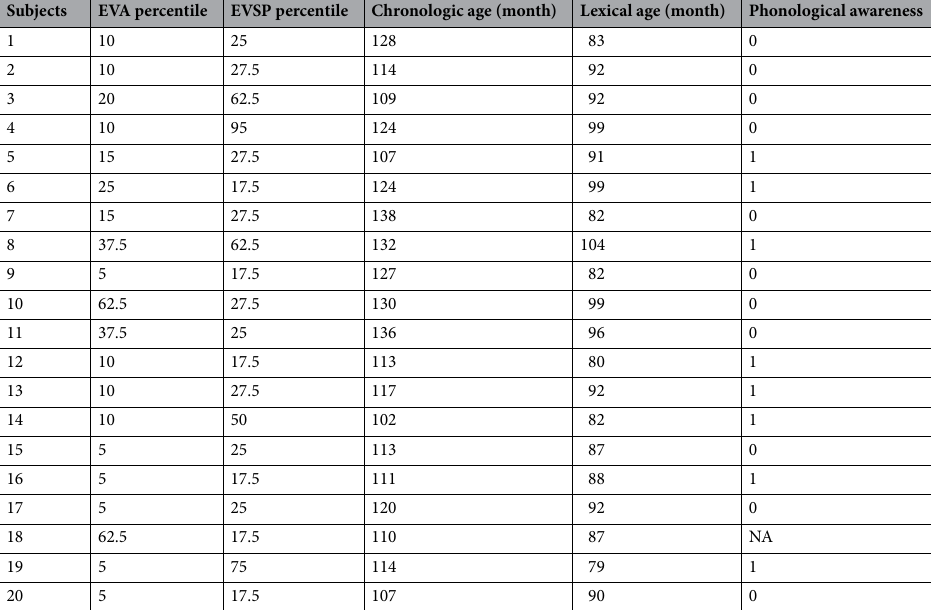
Table 2. Behavioral presentation of the sample of children with DD. EVA corresponds to the global report task evaluating the visuo-spatial span 44 . EVSP corresponds to a test evaluating visuo-spatial perception of length, size, angle and relative positions 45 . Lexical age was determined with the Alouette reading test 43 . Phonological awareness tasks consisted of suppression, rime or deletion task, 0 means that the child failed at none, 1 that the child failed at least at one of these tasks. NA: data not available from clinical information.